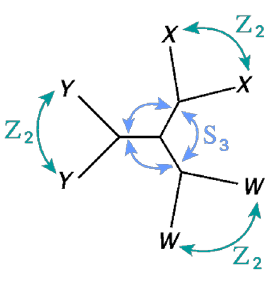
Figure 2 . Permutation symmetries of the star channel identity